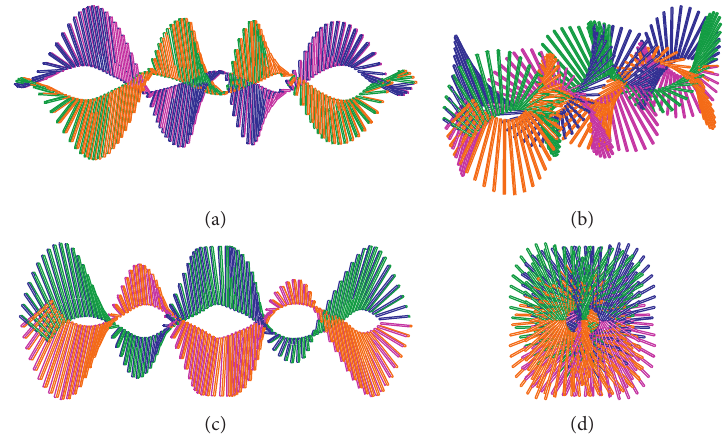
Figure 12: Case study of complex parametric model using the grasshopper logic system (source: drawing by the research team). (a) Top